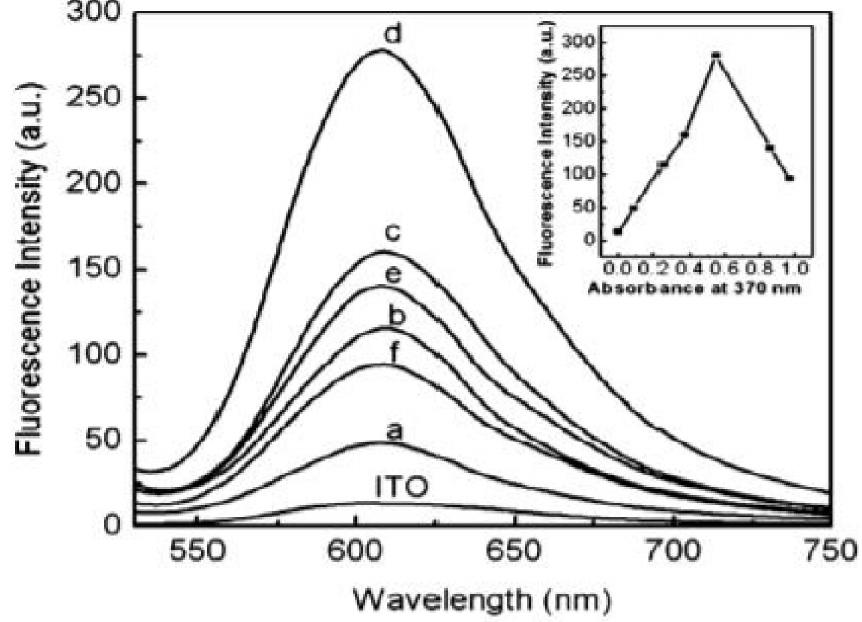
Figure 20. Fluorescence spectra under different electrodeposition times: (a) 10 s; (b) 50 s; (c) 100 s; (d) 200 s; (e) 500 s; and (f) 1000 s. Reprinted with permission from Ref. [178]. Copyright 2007 American Chemical